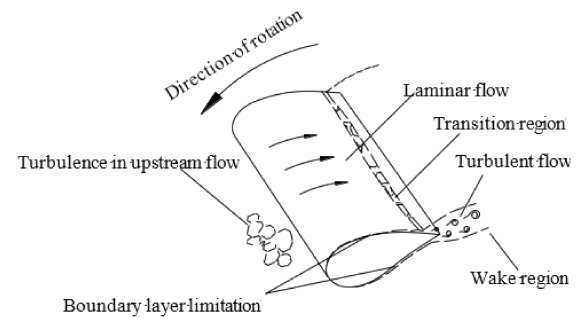
Figure 1. Key regions in a wind turbine